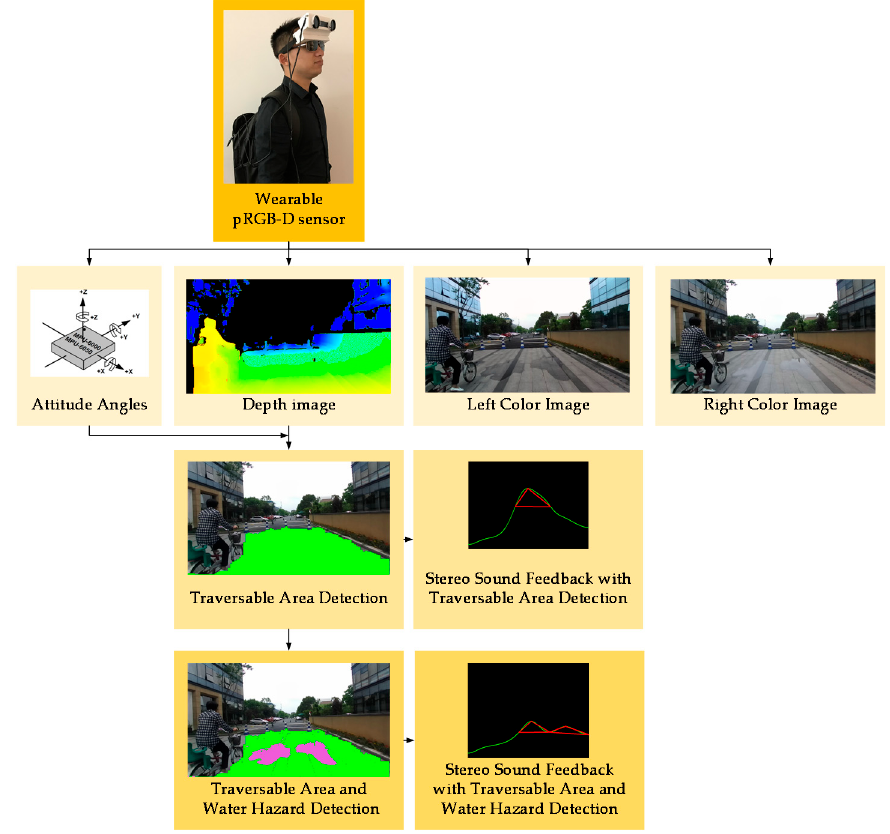
Figure 1. The flow chart of the approach.